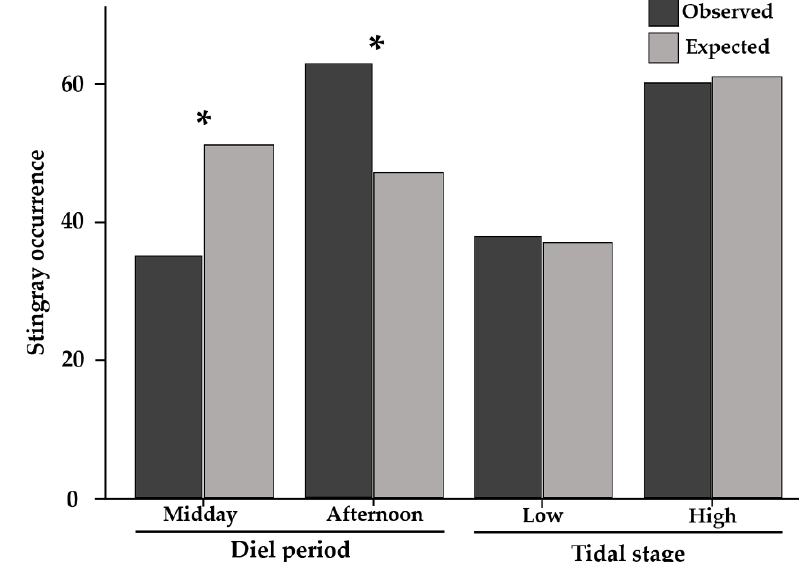
Figure 1. Comparison between the observed (black bars) and expected (grey bars) number of stingray sightings within the study area for each diel period and the tidal stage ( n t = 98). Significant differences ( p < 0.05) in Chi-Square tests of independence are denoted by *.